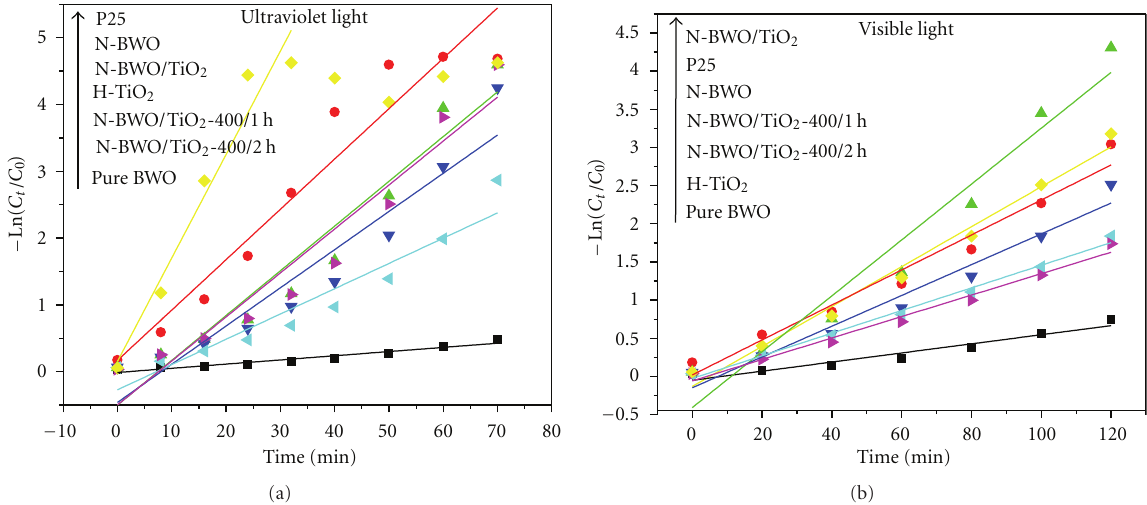
Figure 7: Kinetic fitted curves plots of photocatalytic degradation of RhB (4 × 10 − 5 mol L − 1 ) under ultraviolet light ( < 400nm) (a) and visible light ( > 420nm) (b) irradiation at room temperature in air over the as-prepared catalysts.